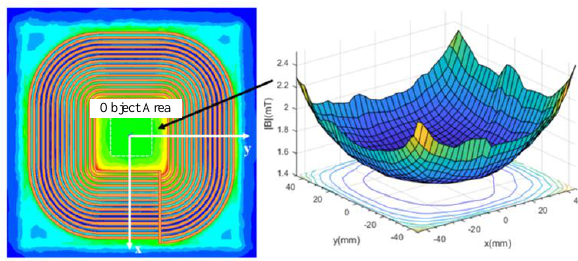
Figure 4. Distribution of magnetic flux density on the transmitting coil surface.